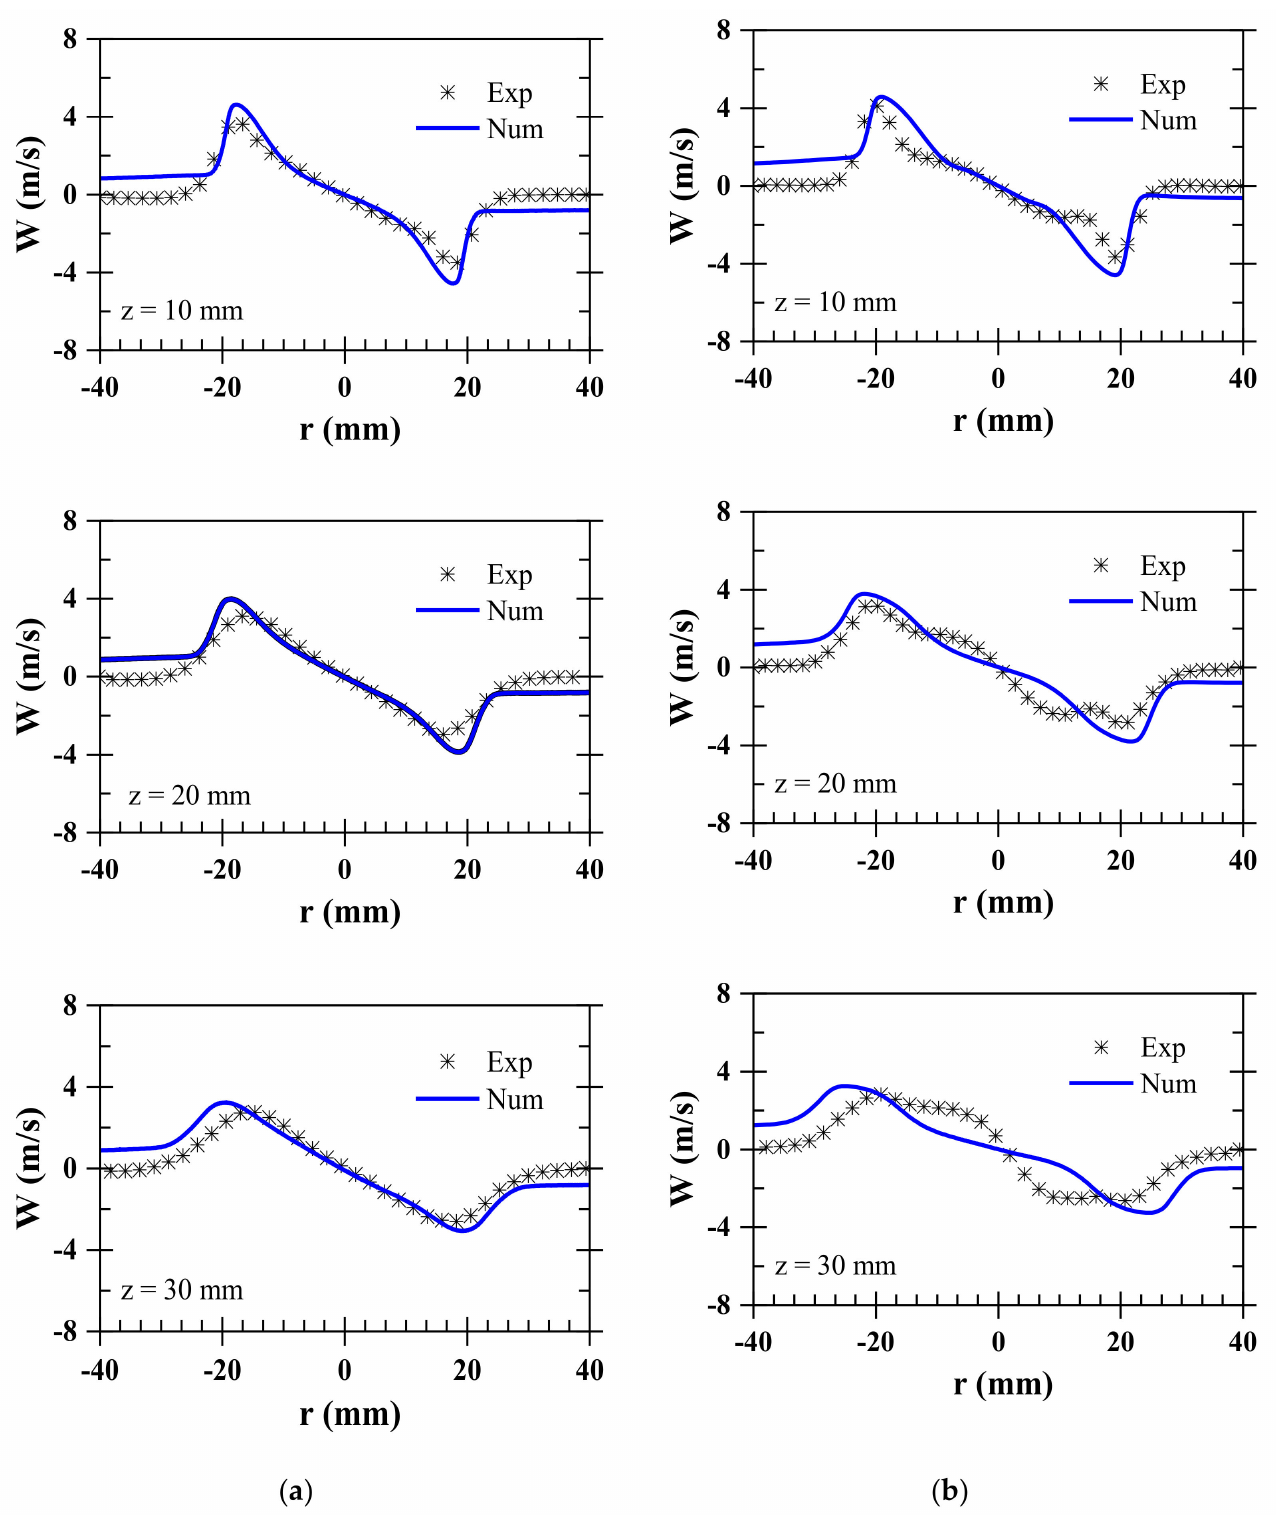
Figure 5. Obtained numerical profiles of the tangential velocity compared to experimental data for non − reacting and reacting cases; ( a ) non − reacting case; ( b ) reacting